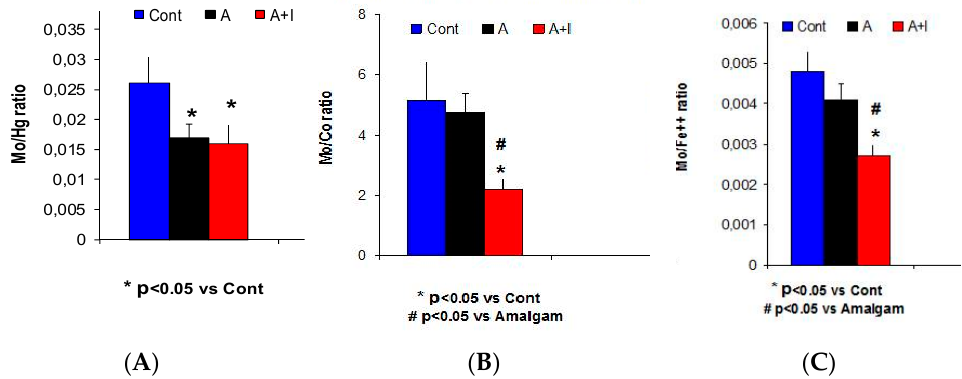
Figure 2. The Mo/Co and Mo/Fe 2+ ratios were significantly decreased in the A + I group as compared Figure-2. The Mo/Co and Mo/Fe ++ ratios were significantly decreased in the A+I group as compared to those with long-term dental amalgams alone A ( A ) The Mo/Hg 2+ ratio is significantly reduced in to those with long-term dental amalgams alone A ( A ) The Mo/Hg ++ ratio is significantly reduced in both experimental groups with dental biomaterials (A + I or A) as compared to controls. The Mo/Co both experimental groups with dental biomaterials (A+I or A) as compared to controls. The Mo/Co ratio ( B ) as well as Mo/Fe 2+ ratio ( C ) were significantly decreased in A + I patients as compared to ratio ( B ) as well as Mo/Fe ++ ratio ( C ) were significantly decreased in A+I patients as compared to those those with long-term dental amalgams alone and controls with long-term dental amalgams alone and controls (Cont).